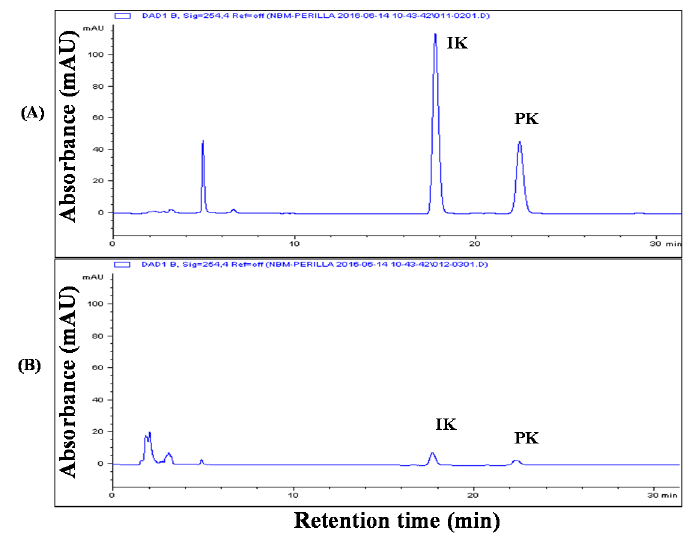
Figure 1. HPLC chromatograms of ( A ) SFE (50 °C, 400 bar, 3 h, and CO 2 flow rate of 60 mL/min) and ( B ) EE (shaking incubation for 6 h at 60 °C) at 254 nm.